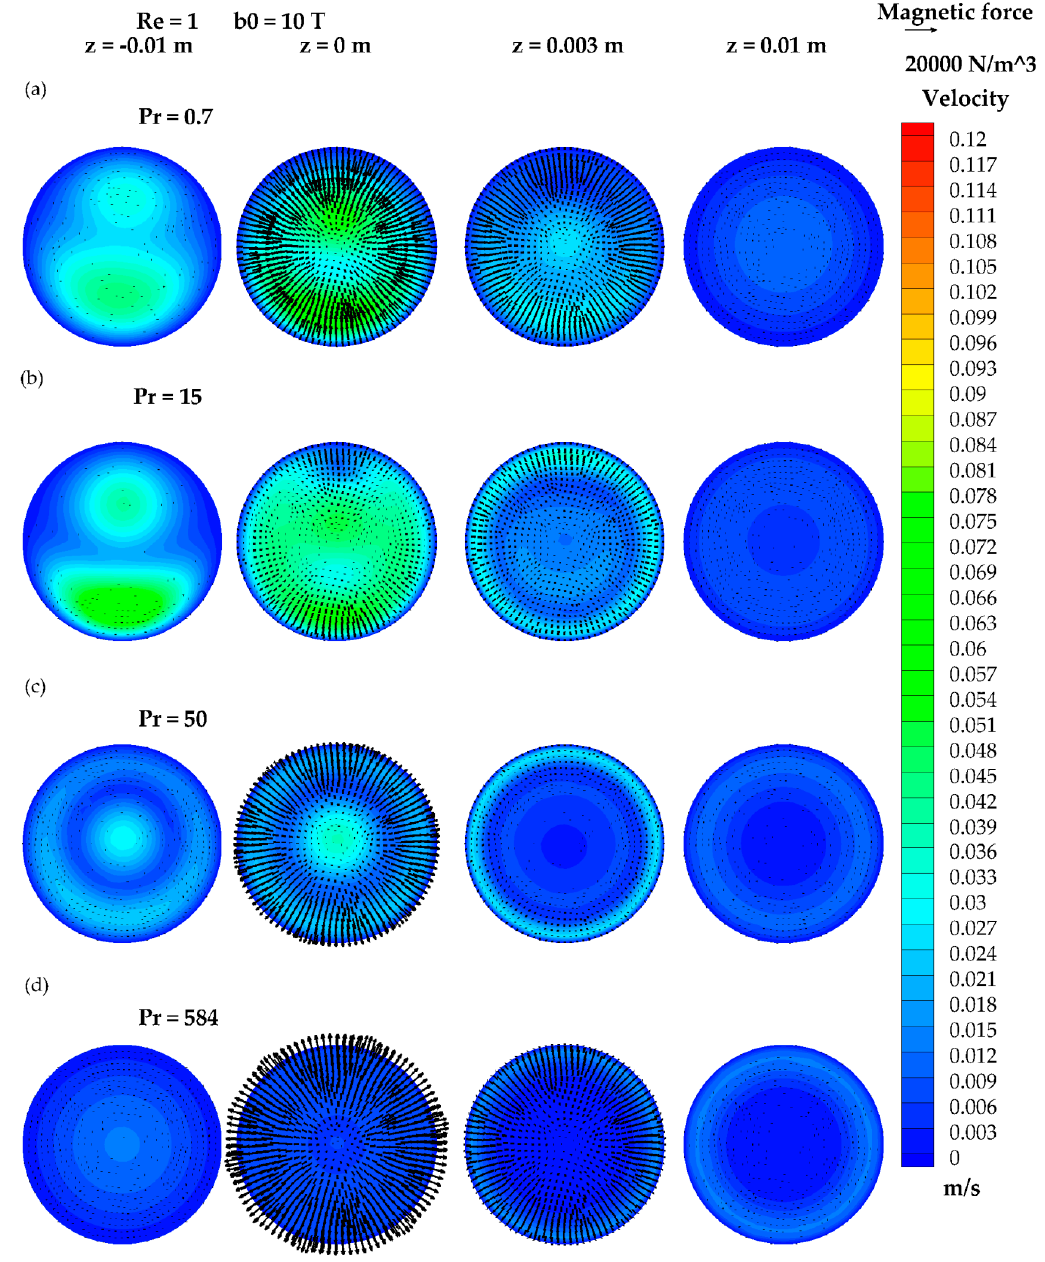
Figure 10. Flow structure in the radial cross-sections ( z = − 0.01 m, 0 m, 0.003 m, 0.01 m) at Re = 1 and b 0 = 10 T: ( a ) Pr = 0.7, ( b ) Pr = 15, ( c ) Pr = 50, ( d ) Pr = 584.